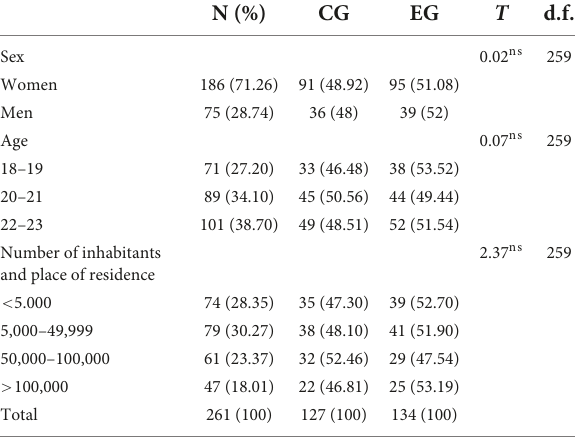
TABLE 6 Sociodemographic data for the sample in Study